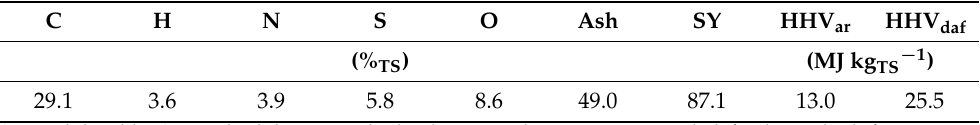
Table 5. Elemental composition of the resulting hydrochar after optimization.